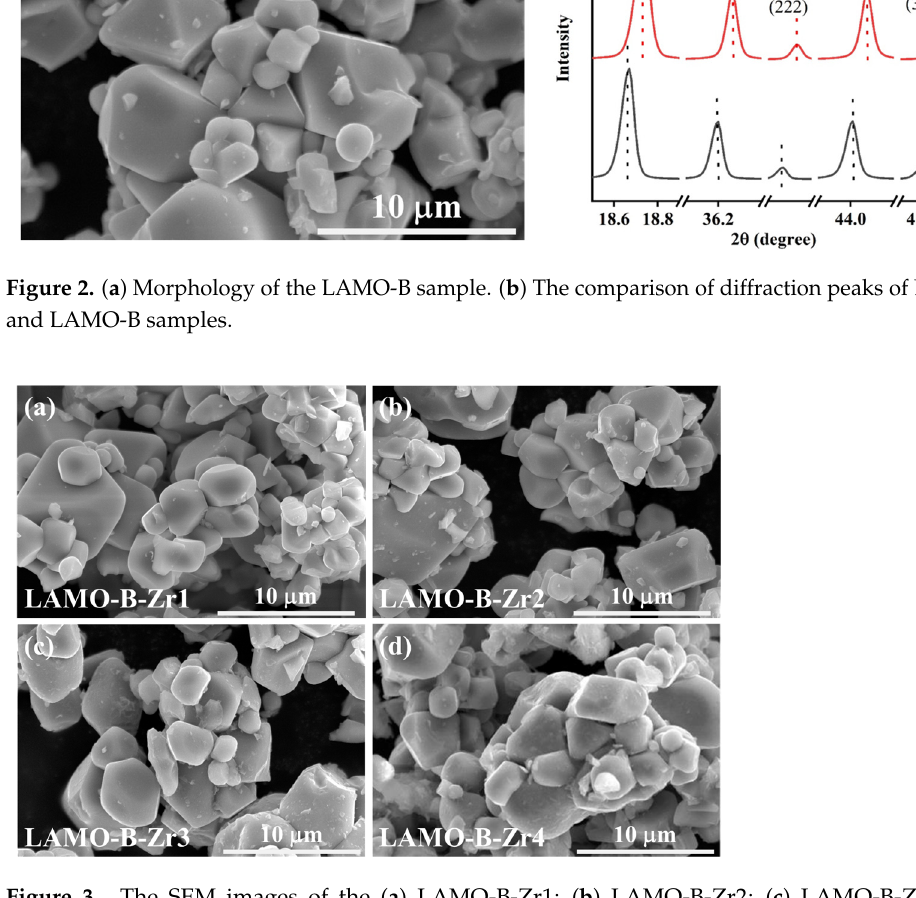
Figure 2. ( a ) Morphology of the LAMO-B sample. ( b ) The comparison of diffraction peaks of LMO- B and LAMO-B samples.